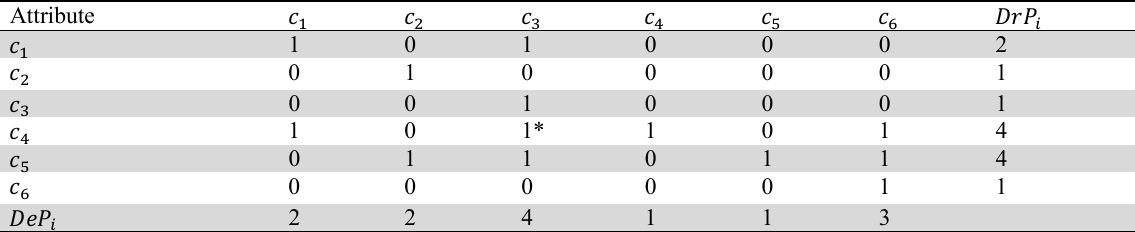
Driving and dependence power of each